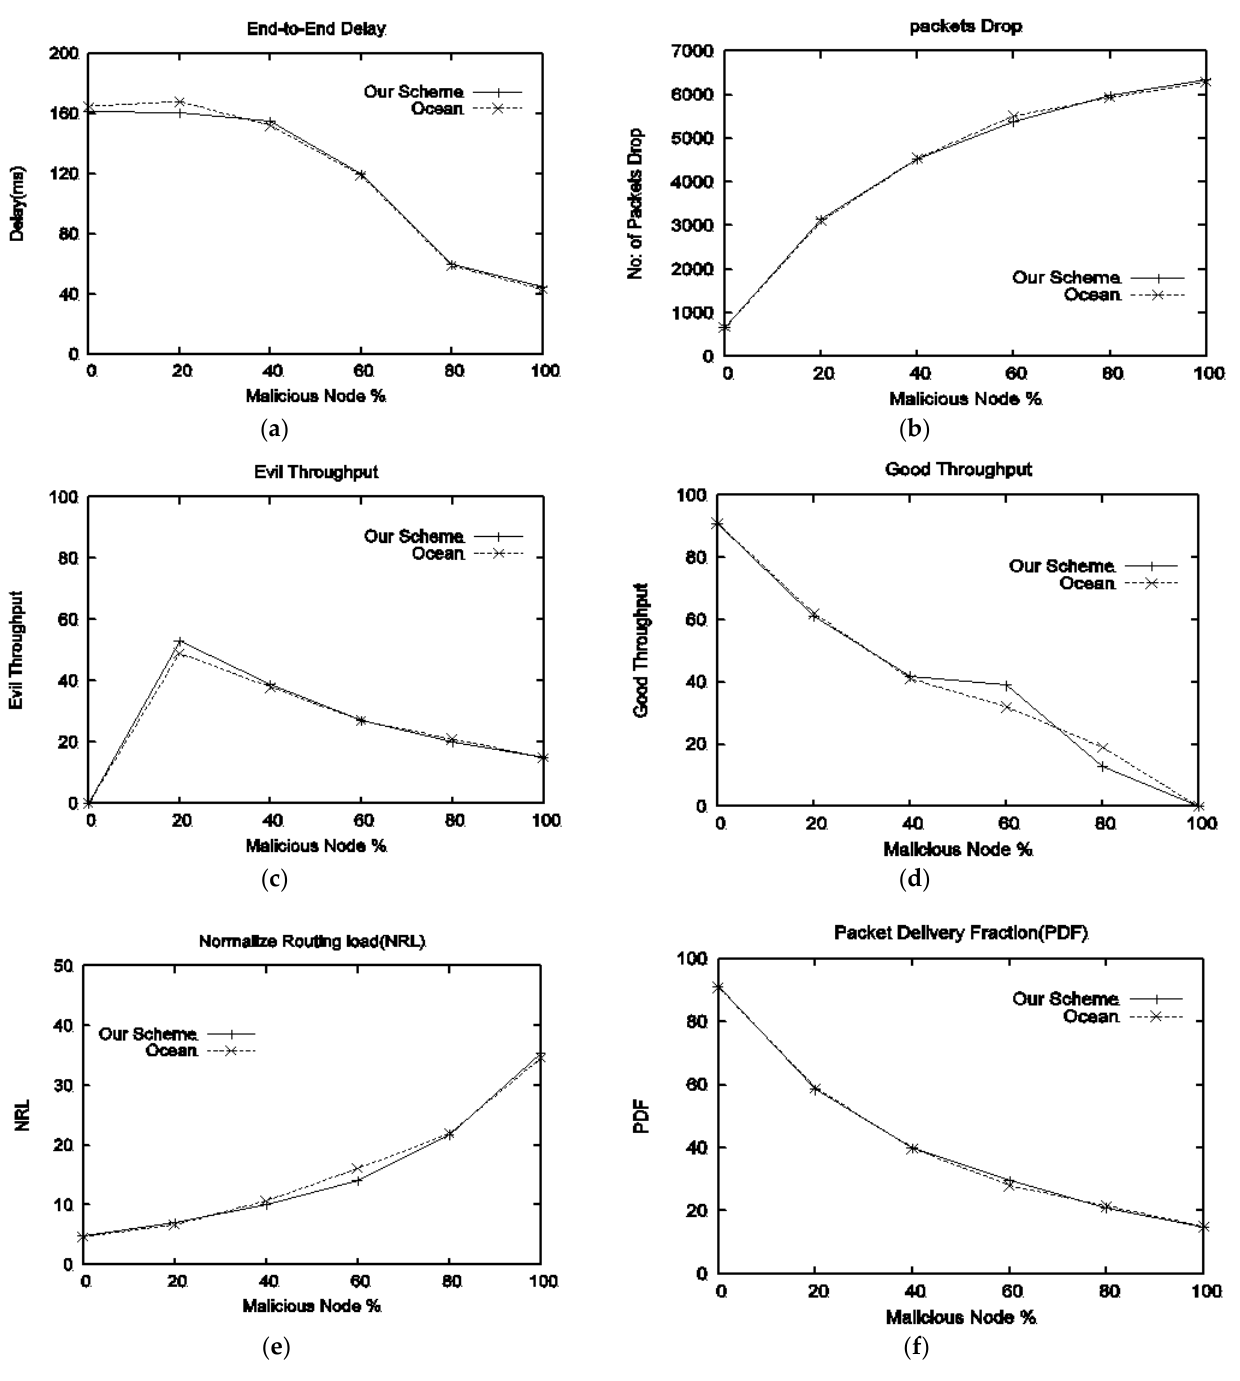
Figure 6. Performance comparison with respect to varying number of malicious percentage: ( a ) delay vs. malicious nodes, ( b ) average drop packets vs. malicious modes, ( c ) evil throughput vs. malicious nodes, ( d ) good throughput vs. malicious nodes, ( e ) NRL vs. malicious nodes, ( f ) PDF vs. malicious nodes.